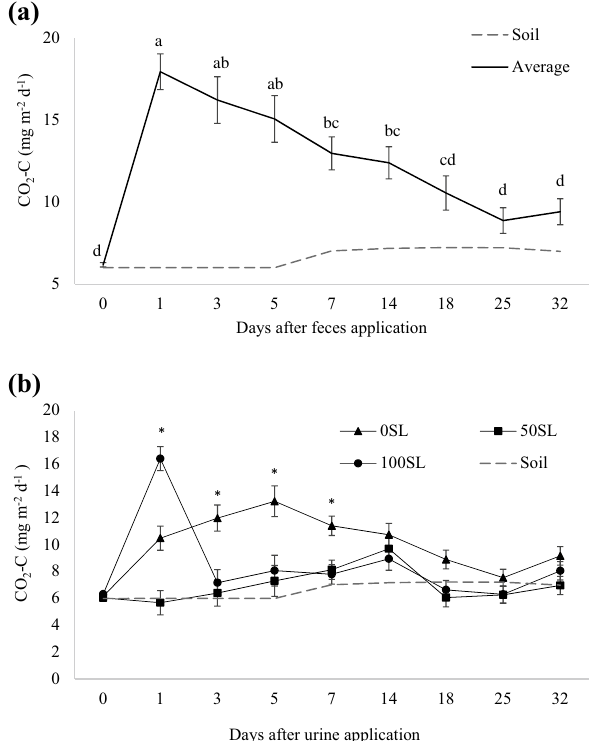
Figure 4. Net flux of CO 2 emitted by ( a ) feces from beef steers fed 0, 50 or 100% sericea lespedeza [SL; Lespedeza cuneata (Dum. Cours.) G. Don], where values represent the average of three diets (0, 50 or 100% SL) in two experimental periods, and means followed by different letters are significantly different among sampling days ( P day < 0.001); and ( b ) urine collected from beef steers fed 0SL, 50SL or 100SL, where asterisk indicates differences among diets within day ( P SL*Day < 0.001). Bars refer to standard deviation. Dashed line represents soil (no excreta) emissions.